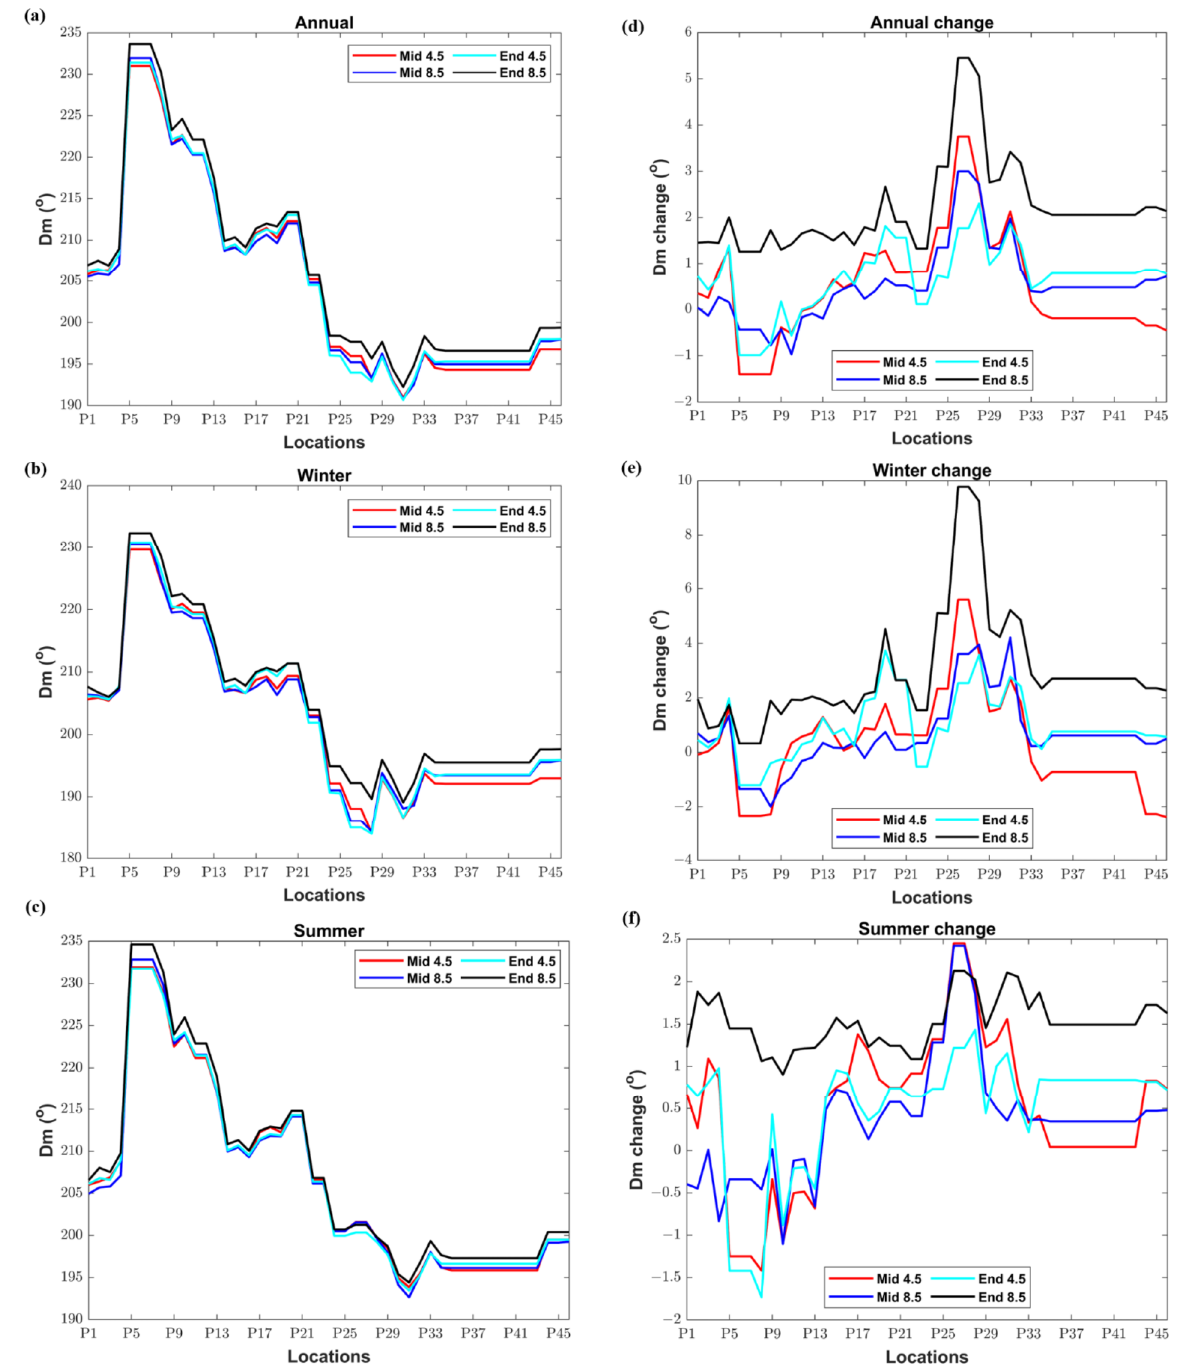
Figure 12. Line plots of the extreme Dm presented as averages for ( a ) annual ( b ) winter, and ( c ) summer and average change in extreme Dm relative to the past for all future time slices and RCP scenarios for ( d ) annual ( e ) winter, and ( f ) summer.